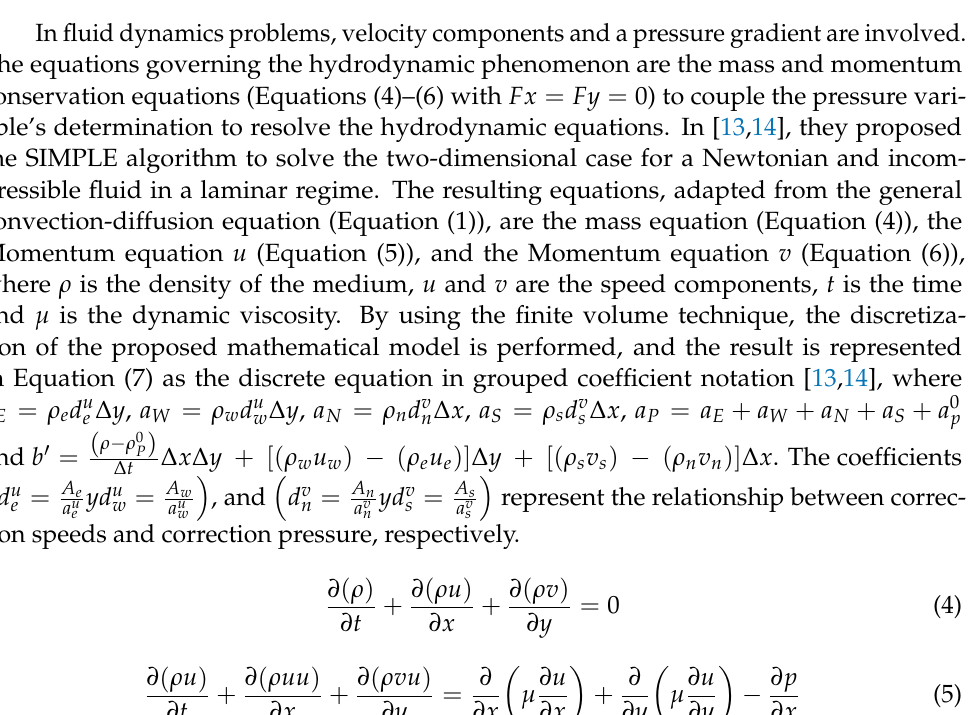
Figure 2. Hydrodynamic problem, Driven-Cavity (physical model)